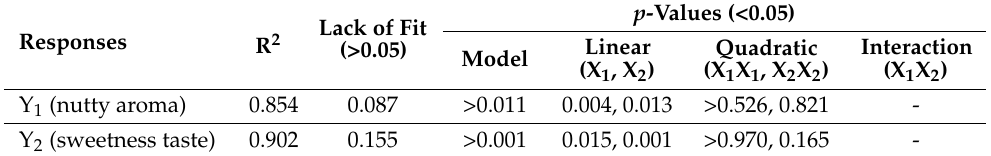
Table 11. Analysis of variance for responses on the optimization of mixing conditions for drone pupae powder and honey with a puffed-rice snack: X 1 , drone pupae powder; X 2 , honey; Y 1 , nutty aroma; Y 2 , sweetness